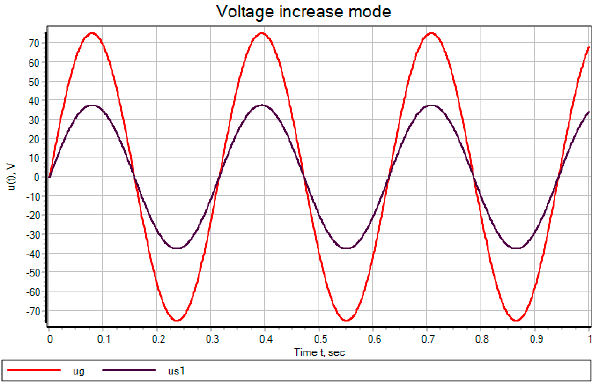
Figure 10. Generated current and voltage.